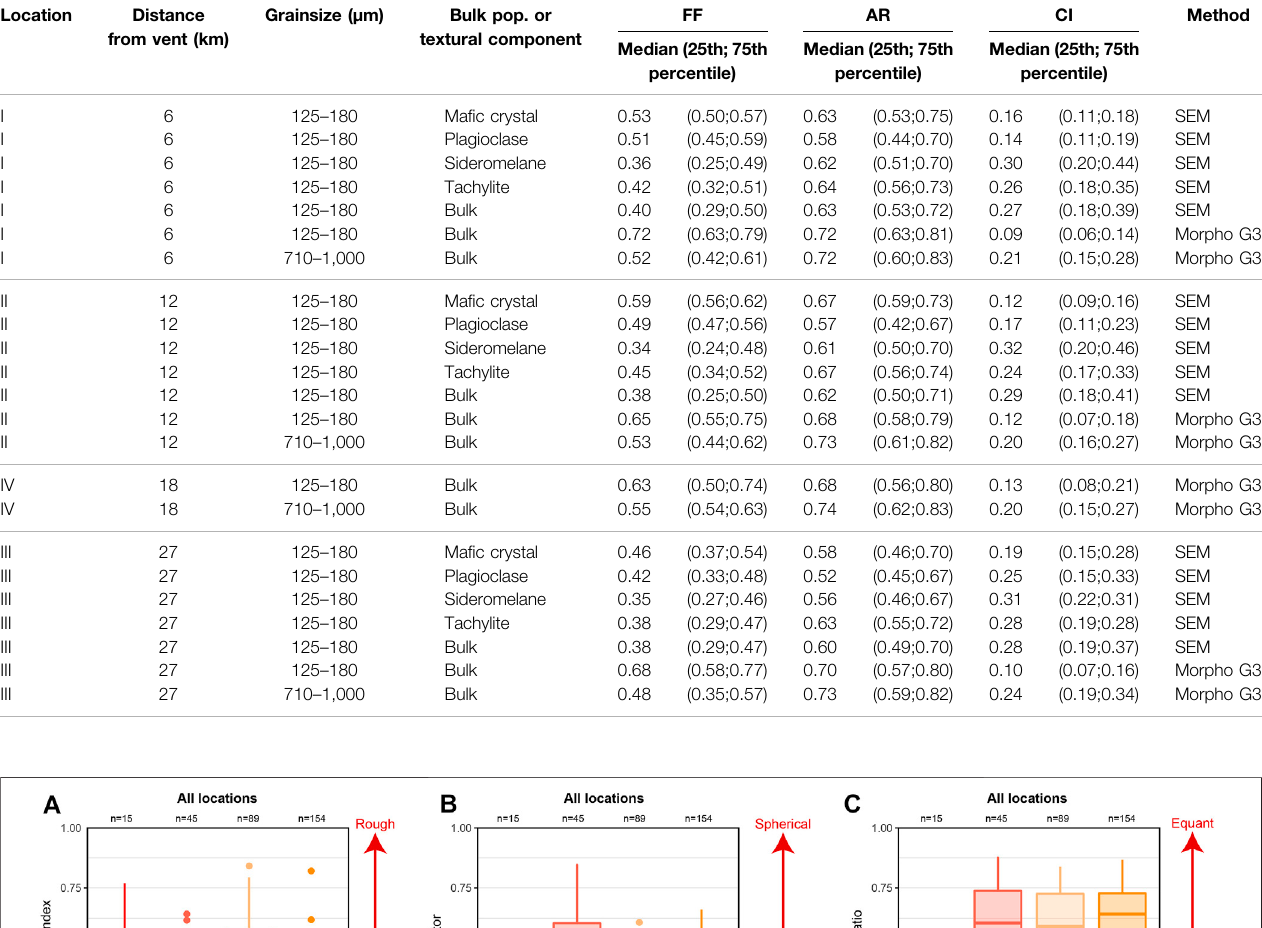
TABLE 2| Main2D Morphological parameter ofthe bulkgrainpopulationin the 1,000 – 710 μ m and 125 – 180 μ m fractions, and the textural components inthe 125 – 180 μ m fraction, of the Etna 21 May tephra fall deposit at varying distances from vent (Morpho G3 and SEM measurements). Location Distance from vent (km)